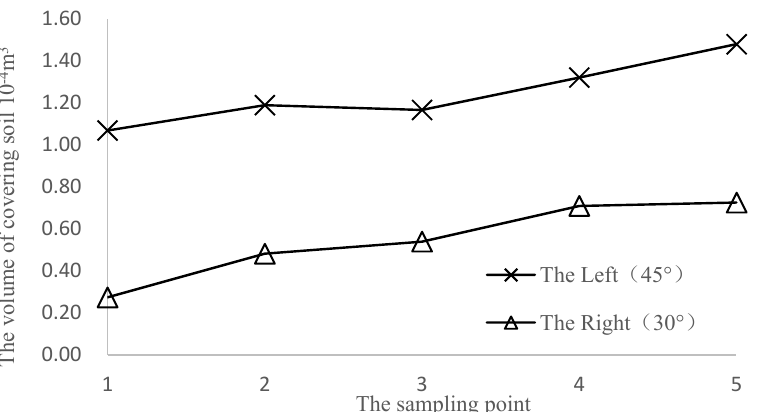
Figure 8. The volume of covered soil at different sampling points (Both the angles of left and right disc are 45 ◦ and 30 ◦ , respectively).